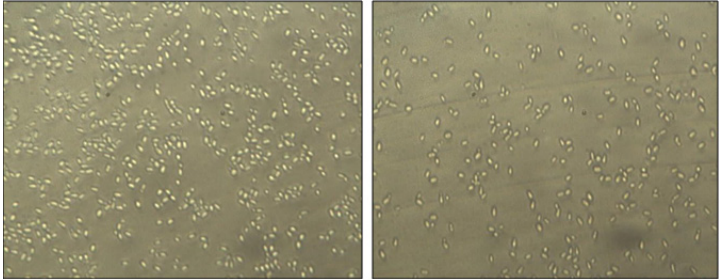
Fig. 6. Inverted microscopic pictures of adhesion, showing the decrease in number of adherent C. albicans (ATCC 10261) cells treated with MIC of geraniol (B), while cells in control (A) show a large number of adherent cells in the absence of